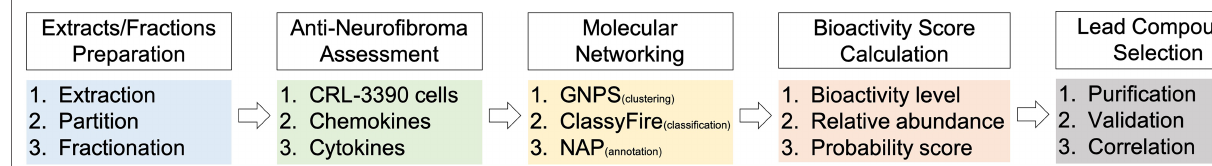
FIGURE 1 | The multi-informative molecular networking (MIMN) workflow for discovering anti-neurofibroma